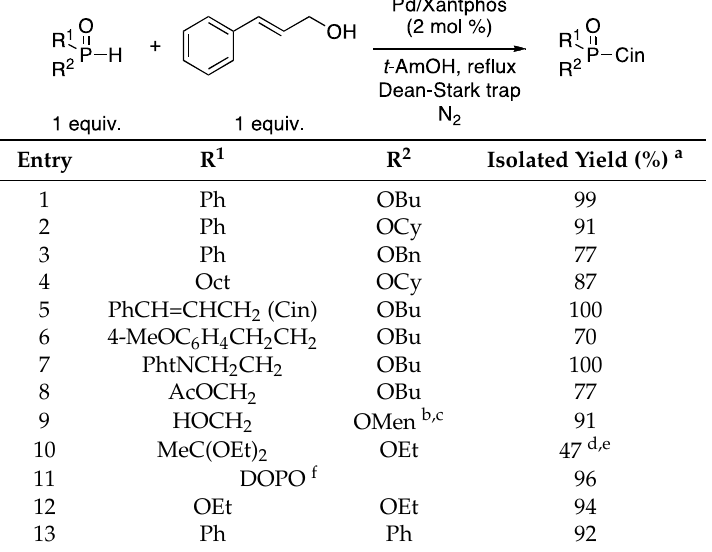
Table 2. Allylation of various phosphinylidene compounds with cinnamyl alcohol.